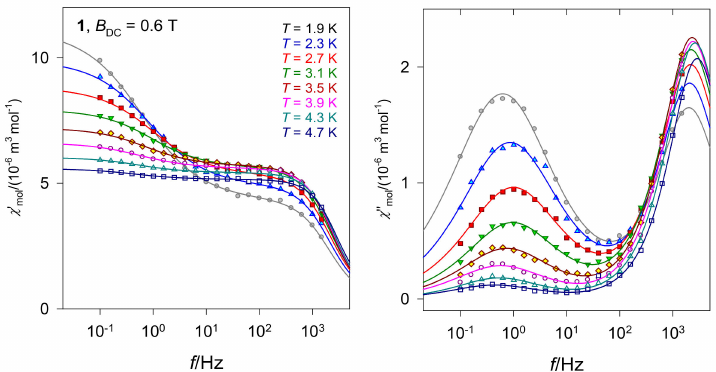
Figure 7. Frequency dependence of the AC susceptibility components of 1 for a set of temperatures